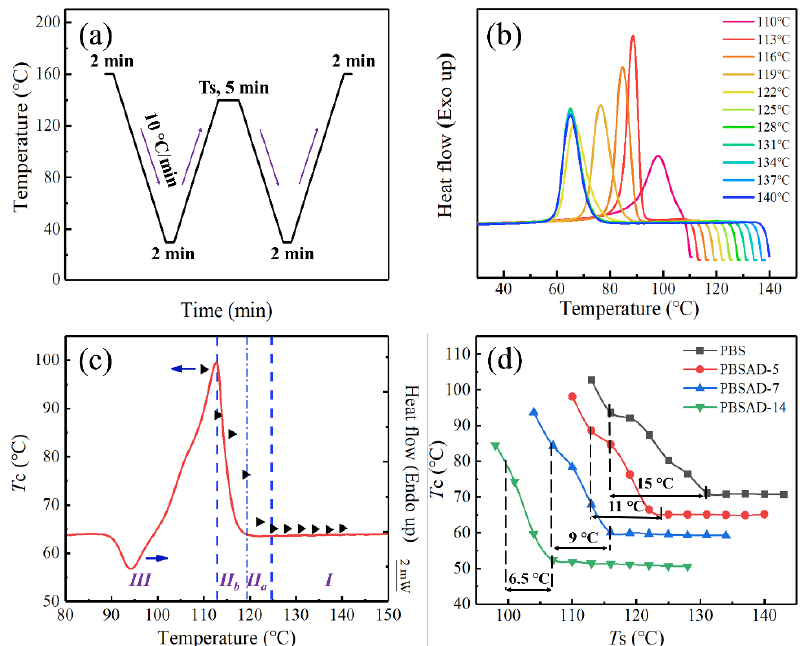
Figure 8. ( a ) Schematic representation of melt memory effect measurement procedure, and ( b ) the cooling DSC curves of PBSAD-5 after being melted at various T s for 5 min. ( c ) A typical plot of the domains for PBSAD-5 (the red, solid line is the melting DSC curve, the solid triangles represent the crystallization temperatures obtained after melting at different T s ). ( d ) The crystallization temperature trends of PBS and PBSAD after melting at different T s (the temperature intervals marked by the dotted lines are the melt memory range of samples).